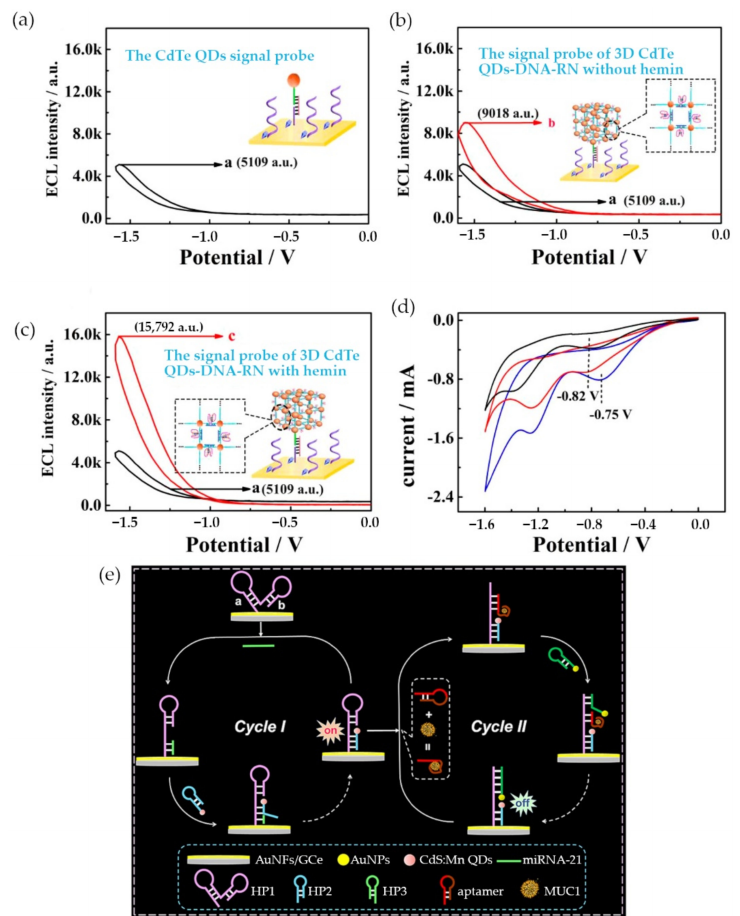
Figure 3. QDs-based electrochemiluminescence (ECL) sensing: ( a ) ECL curve of QDs signal probe; ( b ) ECL curve of 3D QDs-DNA-RN without hemin signal probe; ( c ) ECL curve of 3D QDs-DNA-RN with hemin signal probe; ( d ) cyclic voltammetry responses of the QDs signal probe; ( e ) schematic of the miRNA-21 and MUC1 detection platform. (Reproduced with permission from [26], published by Elsevier 2020; reproduced with permission from [27], published by American Chemical Society